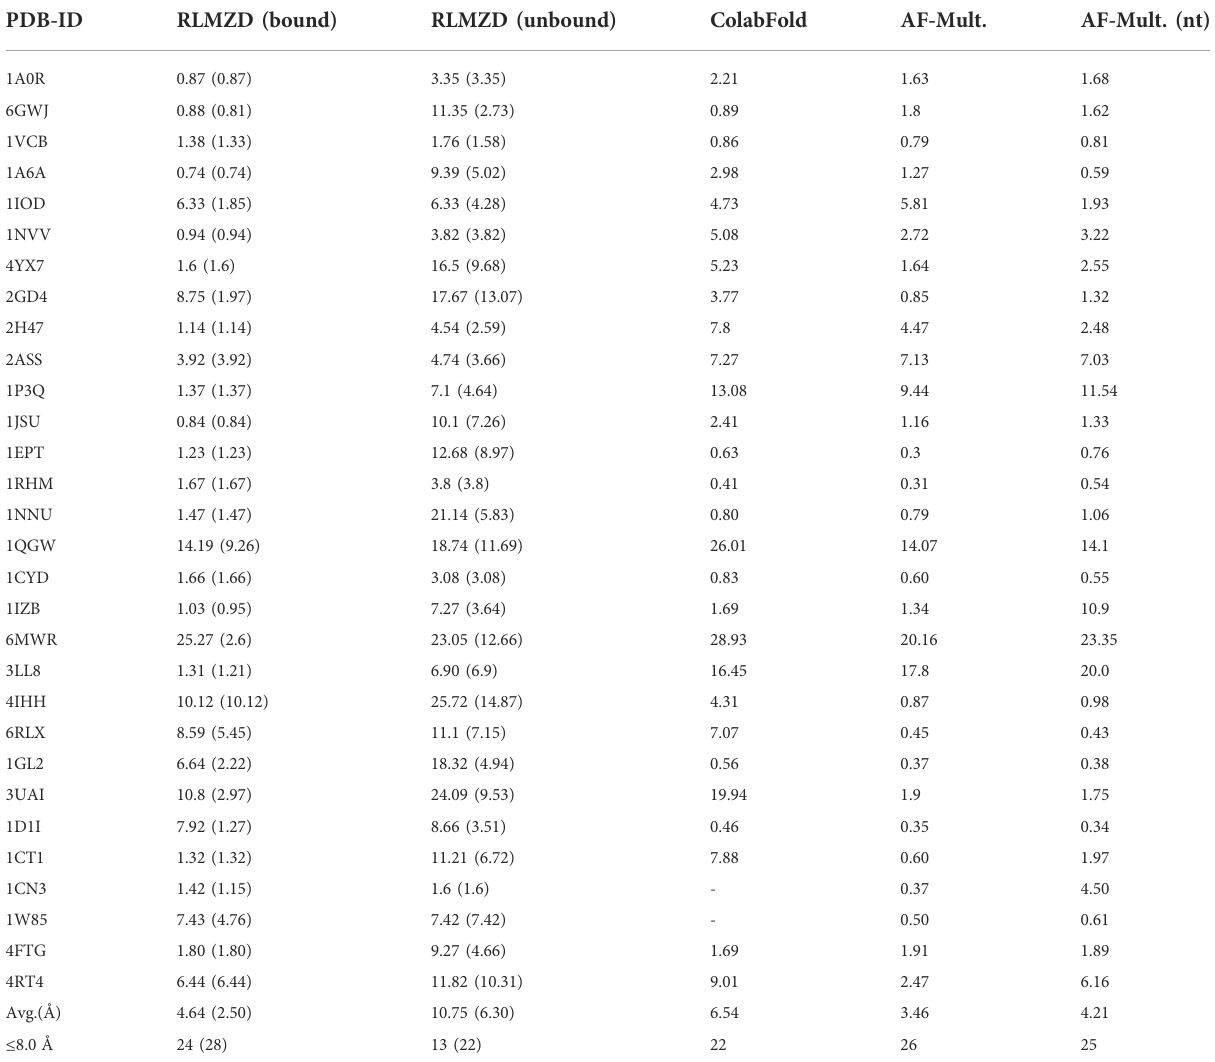
TABLE 3 Comparison of RL-MLZerD against AlphaFold